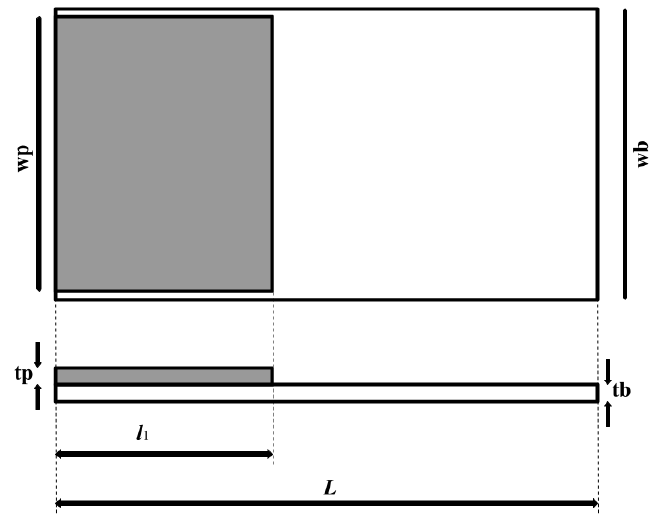
Figure 1. Chosen microcantilever beam design used for the baseline